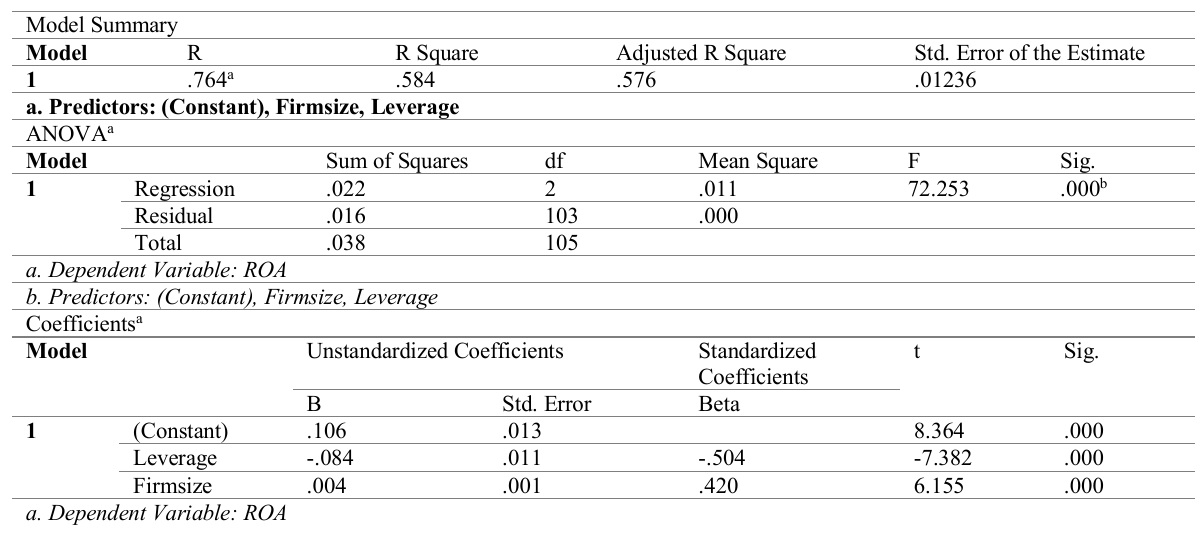
Table 10: Influence of Combined Leverage and Firm Size on Financial